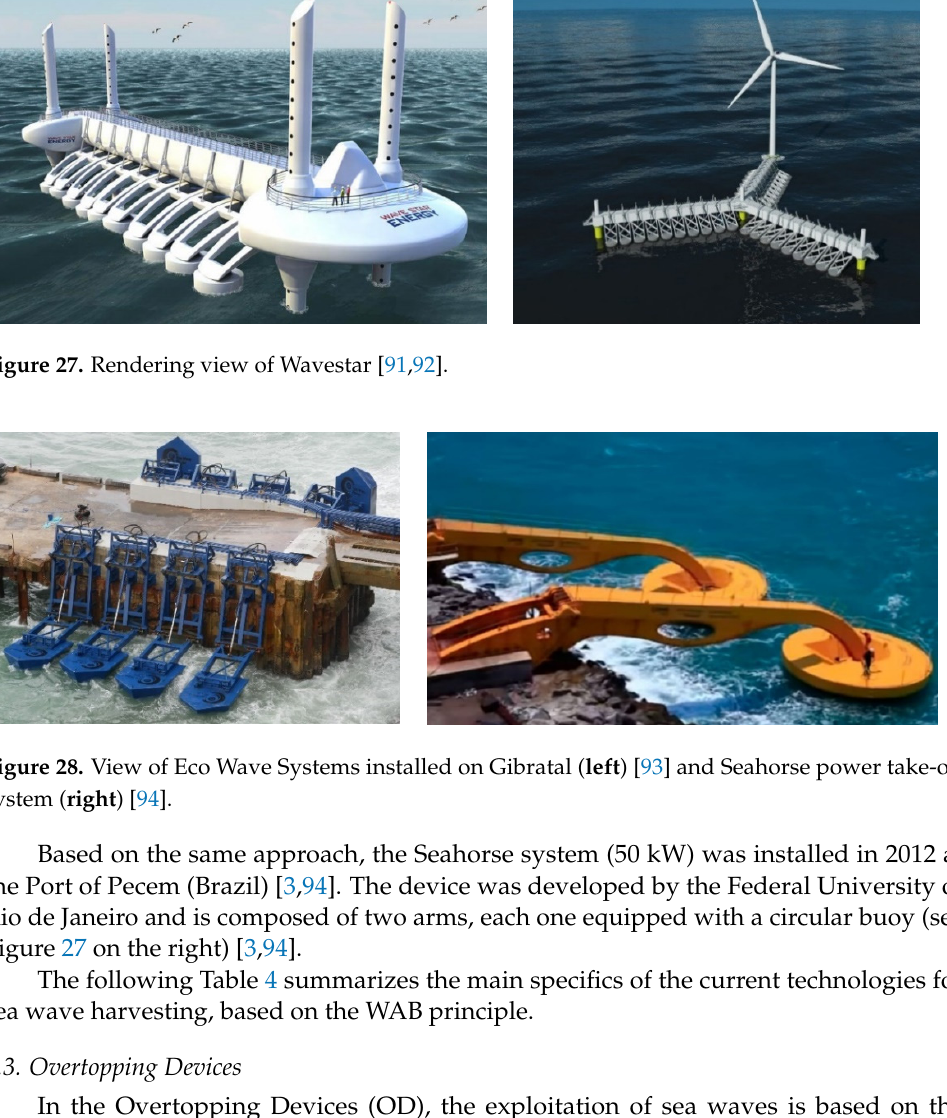
Figure 28. View of Eco Wave Systems installed on Gibratal ( left ) [93] and Seahorse power take-off system ( right ) [94]. Table 4. Summary of the main WAB devices.